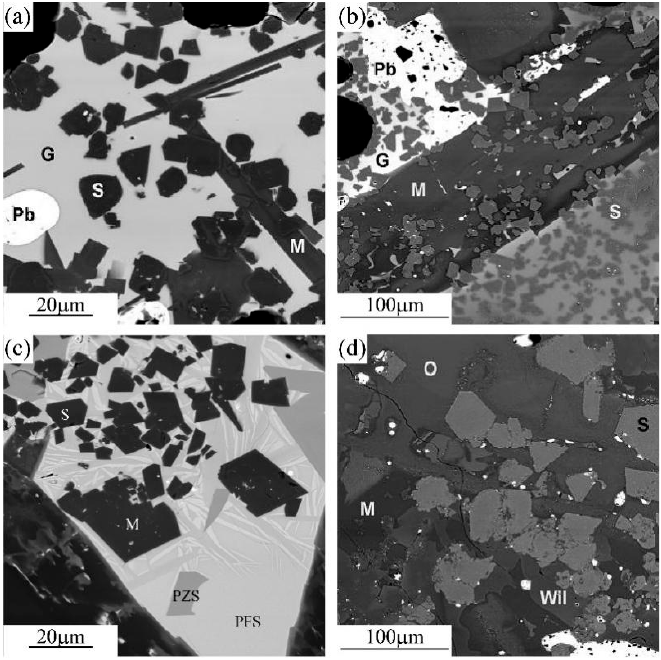
Figure 8. Microstructure of slow-cooled slag of Y2 and Y3 after reaction at 1173 K and 1373 K for 3500 s: ( a ) Y2 1173 K; ( b ) Y2 1373 K; ( c ) Y3 1173 K; ( d ) Y3 1373 K. G = glass, S = spinel, M = melilite, Pb = lead metal, PZS = PbZnSiO 4 , PFS = 6PbO·FeO 1.5 ·SiO 2 , Wil = willemite, O = olivine. Table 4. Compositions of the phases present in the slags after reduction measured by